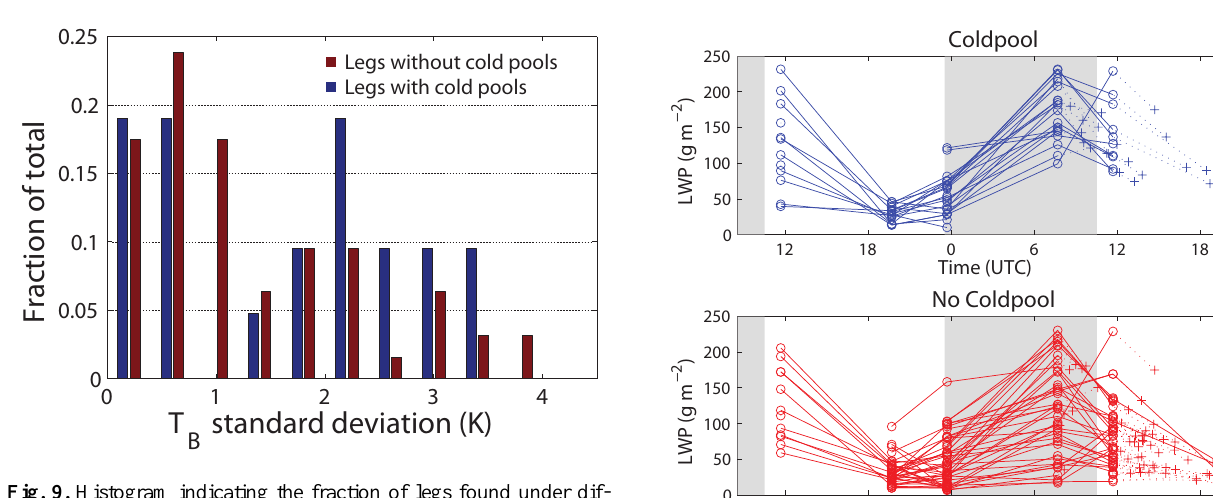
Fig. 9. Histogram indicating the fraction of legs found under dif- ferent cloud fields. Each bar represents the fraction of legs with or without cold pools in which the standard deviation of the brightness temperature ( T B ) of the 1 ◦ box centered on the leg. Fig. 10. Two-degree box-averaged LWP of cloud field along the ECMWF-derived back trajectories flight legs with (blue) and with- out (red) cold pools. Averaged LWP (circles) are plotted against UTC to place the flight legs within the context of the diurnal cycle. The times of the flight legs are indicated by crosses. LWP values of the crosses are estimated by linearly interpolating satellite LWP re- trievals taken before and after the flight legs. Local nighttime hours in the VOCALS REx region are indicated by gray